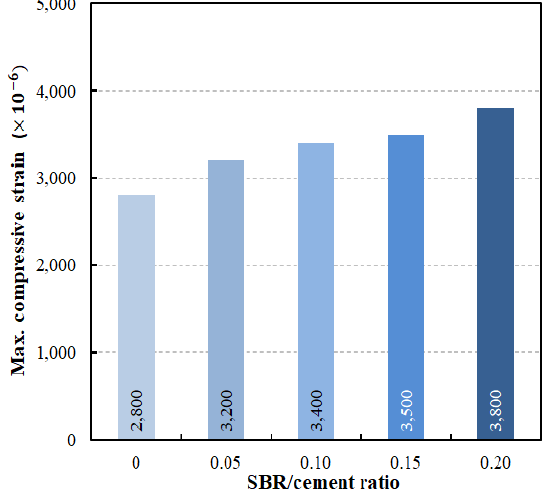
ff erent SBR / cement Figure 7. Maximum compressive strains for different SBR/cement ratios. Figure 7. Maximum compressive strains for di Figure 7. Maximum compressive strains for different SBR/cement ratios.